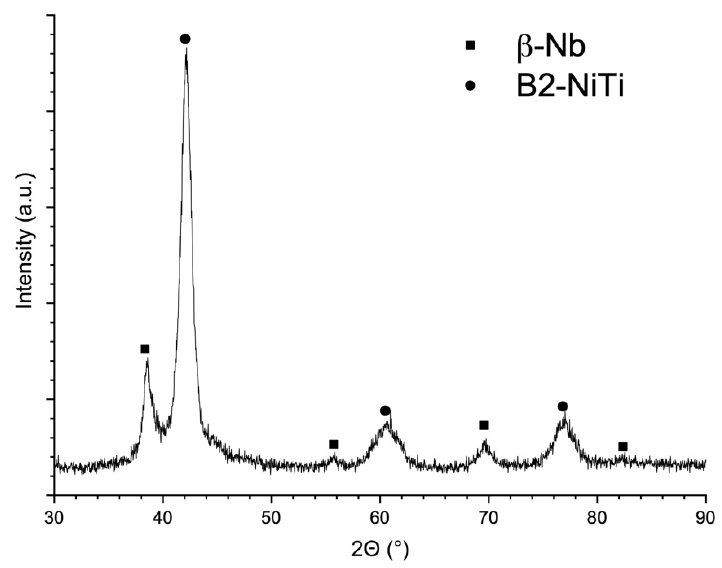
Figure 5. The XRD pattern of the NiTiNb sample produced using the E1 parameter set.